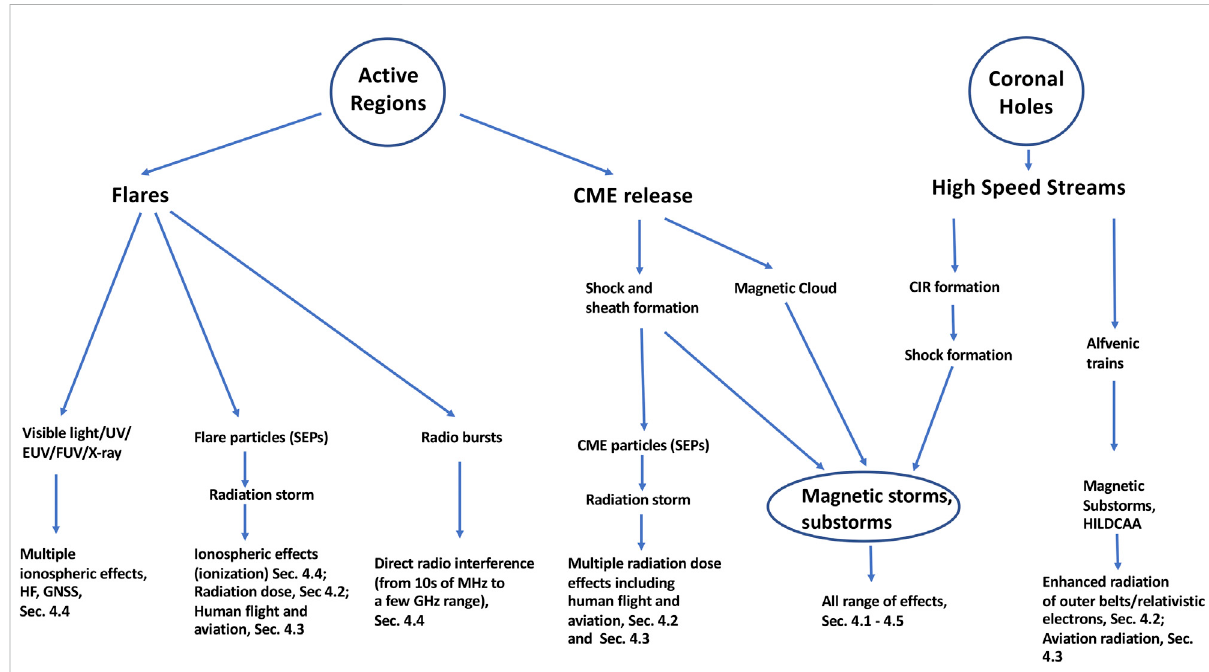
FIGURE 2 Relationship between the main Space Weather processes (solar eruptive processes, and high-speed solar wind) and Space Weather effects/ impacts(itisnotedthatCME/ fl areeventscanalsobedueto fi lamenteruptionsinquietregionandtheboundariesofpolarcoronalholes,butmostof the energetic eruptions originate from active regions). Different Space Weather effects/impacts could occur at the same time due to close association with eruptive processes, but could also occur independently, e.g. radiation storms and geomagnetic